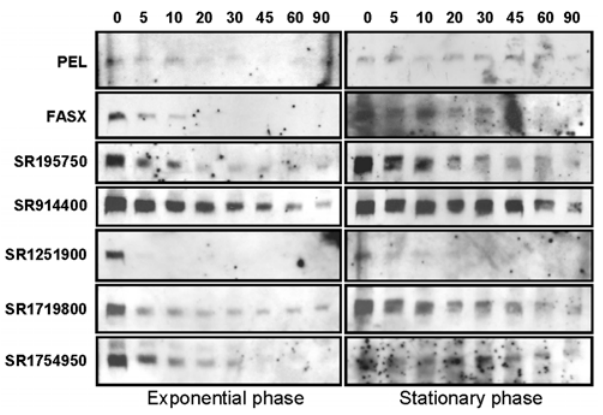
Figure 5. Northern blot analysis of sRNA stability. Aliquots of mid-exponential or late stationary phase cultures of strain MGAS2221 were harvested prior to (T=0) and following (T=5, 10, 20, 30, 45, 60, 90 min) rifampicin treatment to inhibit new RNA synthesis. 8 m g of extracted RNA from each time-point was subjected to Northern blot analysis, probing for PEL, FASX, SR195750, SR914400, SR1251900, SR1719800, and SR1754950 transcripts. Note that as the exposure time of each Northern blot varied no comparison of band intensities between blots should be made.